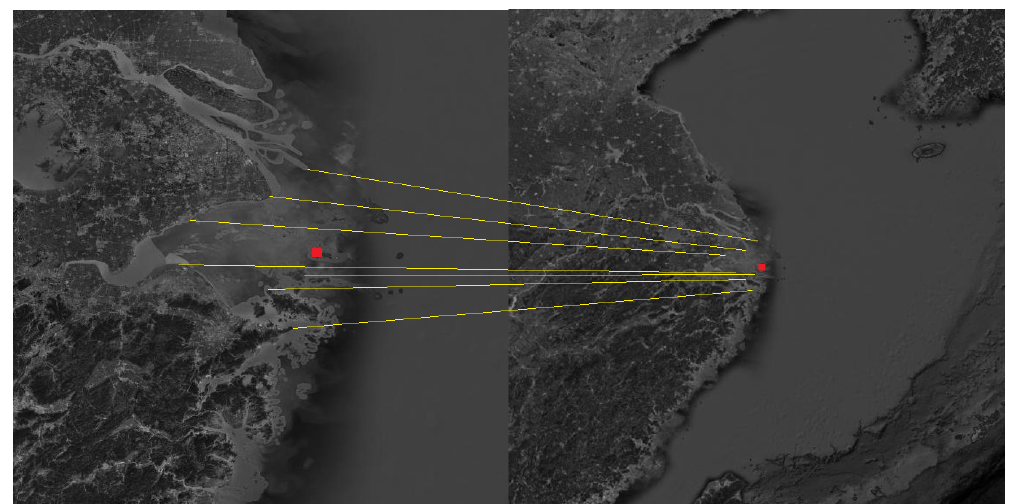
Figure 7. Schematic diagram of the matching process about the Yangtze River Delta.